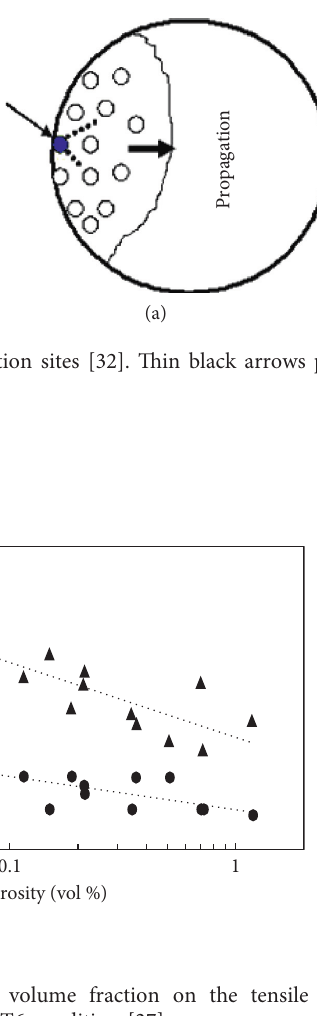
Figure 11: Stress concentration and its gradient at the pore surface [31].